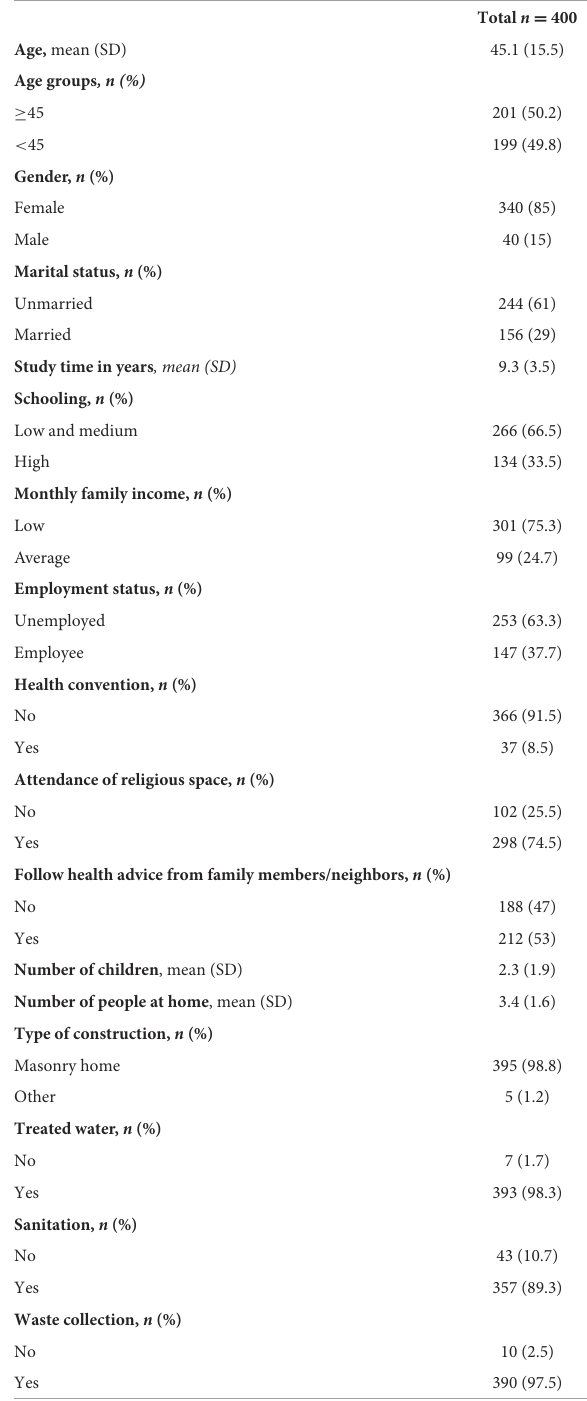
TABLE 1 Population characteristics ( n =